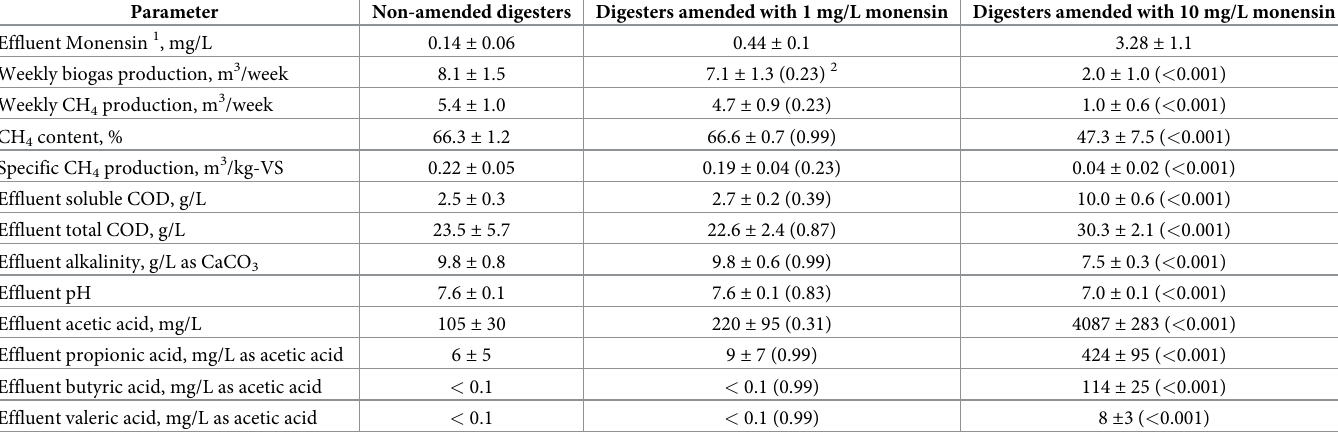
Table 3. Steady state results of field-scale (FS) digesters operated using dairy manure (non-amended) and dairy manure amended with monensin to 1 and 10 mg/L (mean ± std. dev.). Parameter